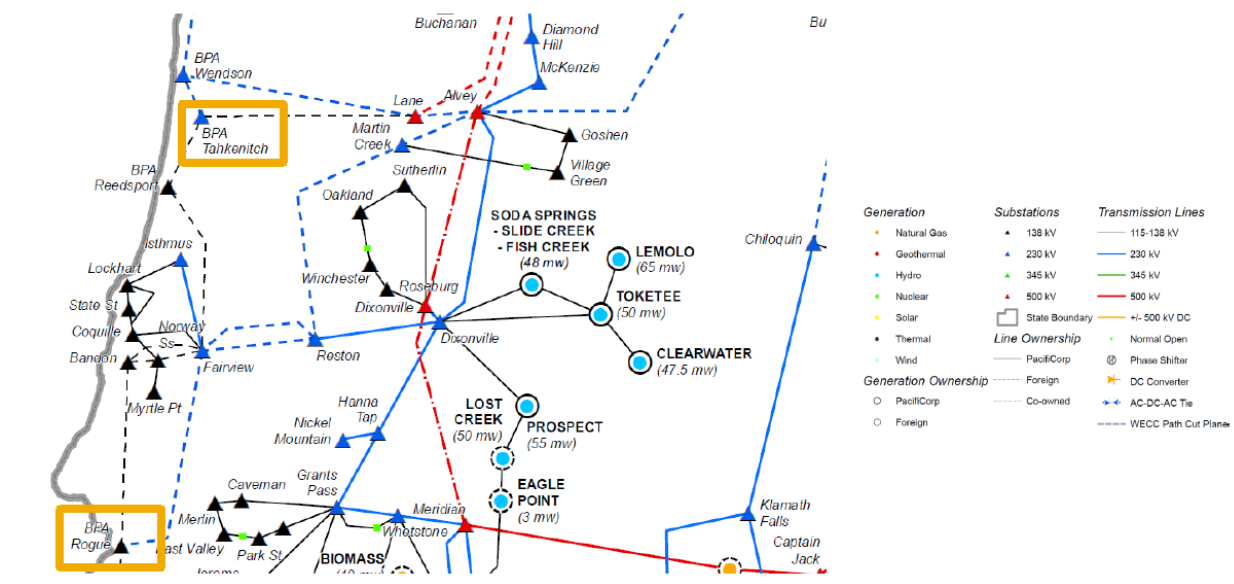
Figure 8. Transmission map for Southern Oregon [28]. OSW interconnection point, Rogue and Tahkenitch substations highlighted in yellow.